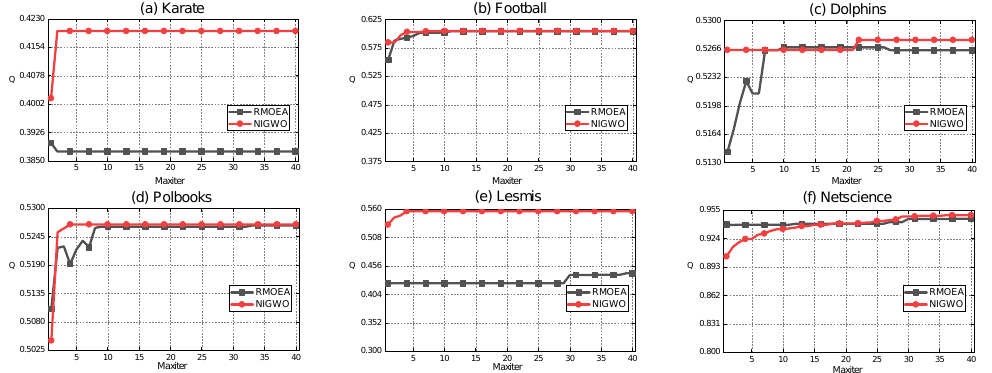
Figure 9. Modularity based on population